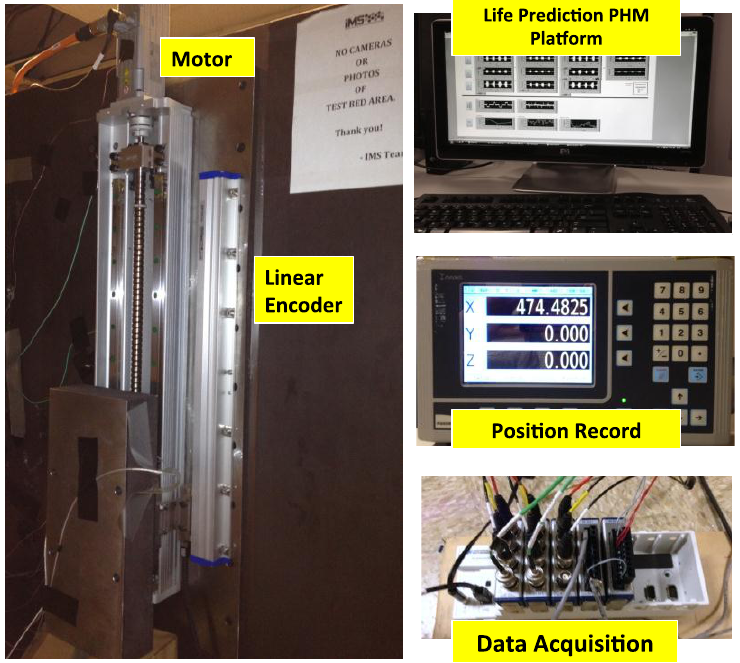
Figure 4. Setup of the Ball Screw Test